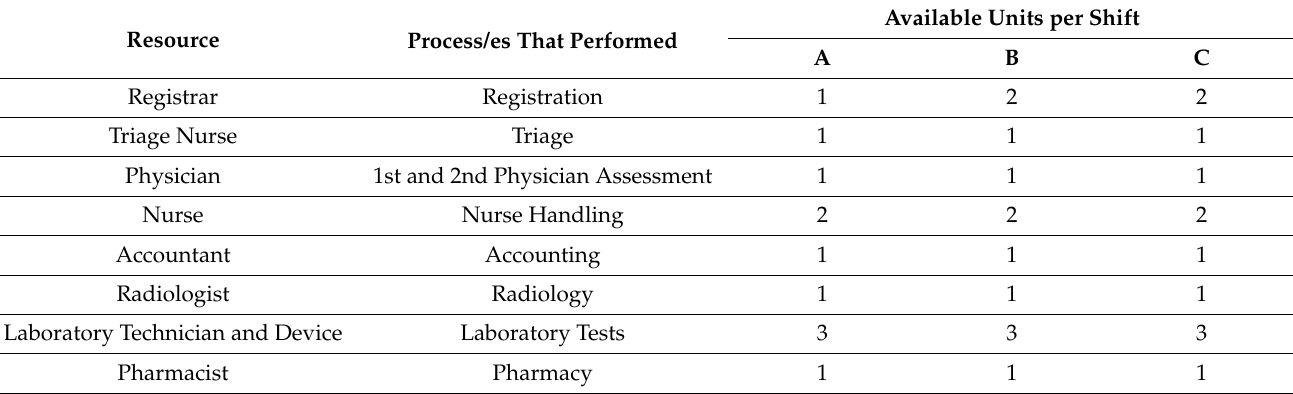
Table 6. The resources available in PRPH’s emergency department